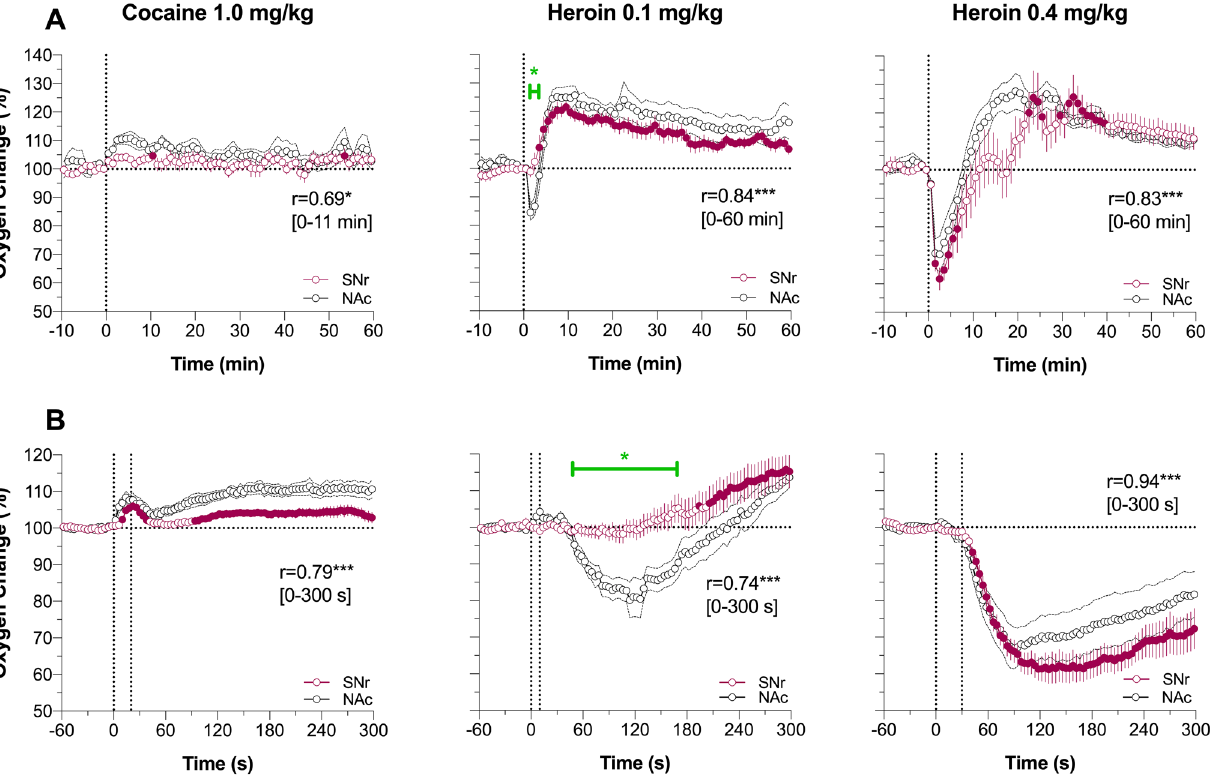
Figure 6. Changes in oxygen levels in substantia nigra pars reticulata (SNr) induced by intravenous cocaine (1.0 mg/kg) and heroin (0.1 and 0.4 mg/kg) in awake, freely moving rats. Comparison with nucleus accumbens data. ( A ) Mean (± SEM) changes in oxygen levels relative to baseline (100%) calculated with 1-min time bins. Vertical hatched lines show onset and offset of stimulus presentation. Filled symbols mark values significantly different from pre-stimulus baseline. r = coefficients of correlations calculated for the time interval to the peak of NAc increase. ( B ) Mean (± SEM) changes in oxygen levels relative to baseline (100%) calculated with 4-s time bins. Green line with asterisk shows significant between-structure differences in oxygen responses. Asterisks show significance of coefficients of correlation (* and ***, P < 0.05, and 0.001, respectively). See Supplementary materials for quantitative results of statistical comparisons (group sizes, ANOVAs F